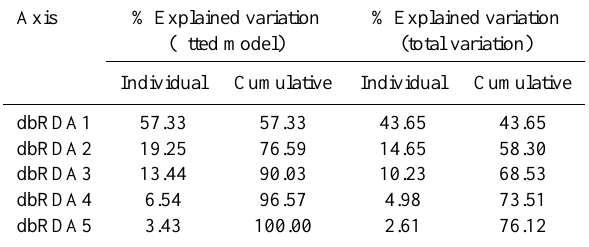
Table 3. Results of distance-based multivariate linear model (Dis- tLM) for bacterial community composition in epipelagic waters showing the % variation explained by individual axes. The first two columns relate to the percentage explained out of the fitted model (individuated with the DistLM analysis). The second two columns relate to the percentage explained out of the total variation in the resemblance matrix used to build up the DistLM